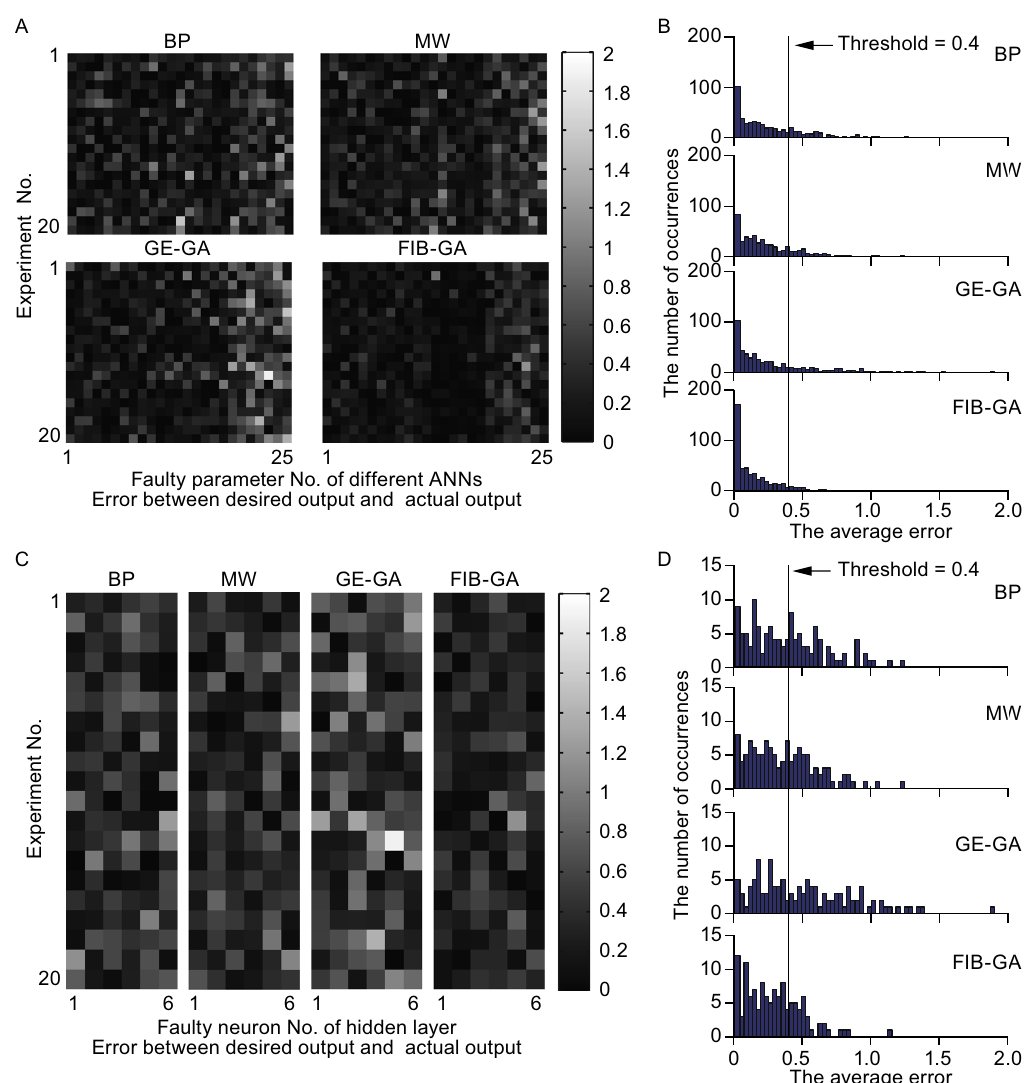
Figure 2. The FT performance of ANNs in solving an XOR problem with a single faulty parameter or neuron in the hidden layer. (AandB)Theplotoferrorsversusthefaultyparameter(A)andahistogramoferroroccurrence(B)in20independentexperiments usingANNs trainedvia BP, MW, GE-GA,and FIB-GAmethods.(C and D) The plot oferrors versus the faultyneuronsin the hiddenlayer (C) and a histogram of error occurrence (D) in 20 independent experiments using ANNs trained via BP, MW, GE-GA, and FIB-GA methods. In panels C and D, a fault output represents a fi tting with the error equal to or exceeding a threshold of 0.4